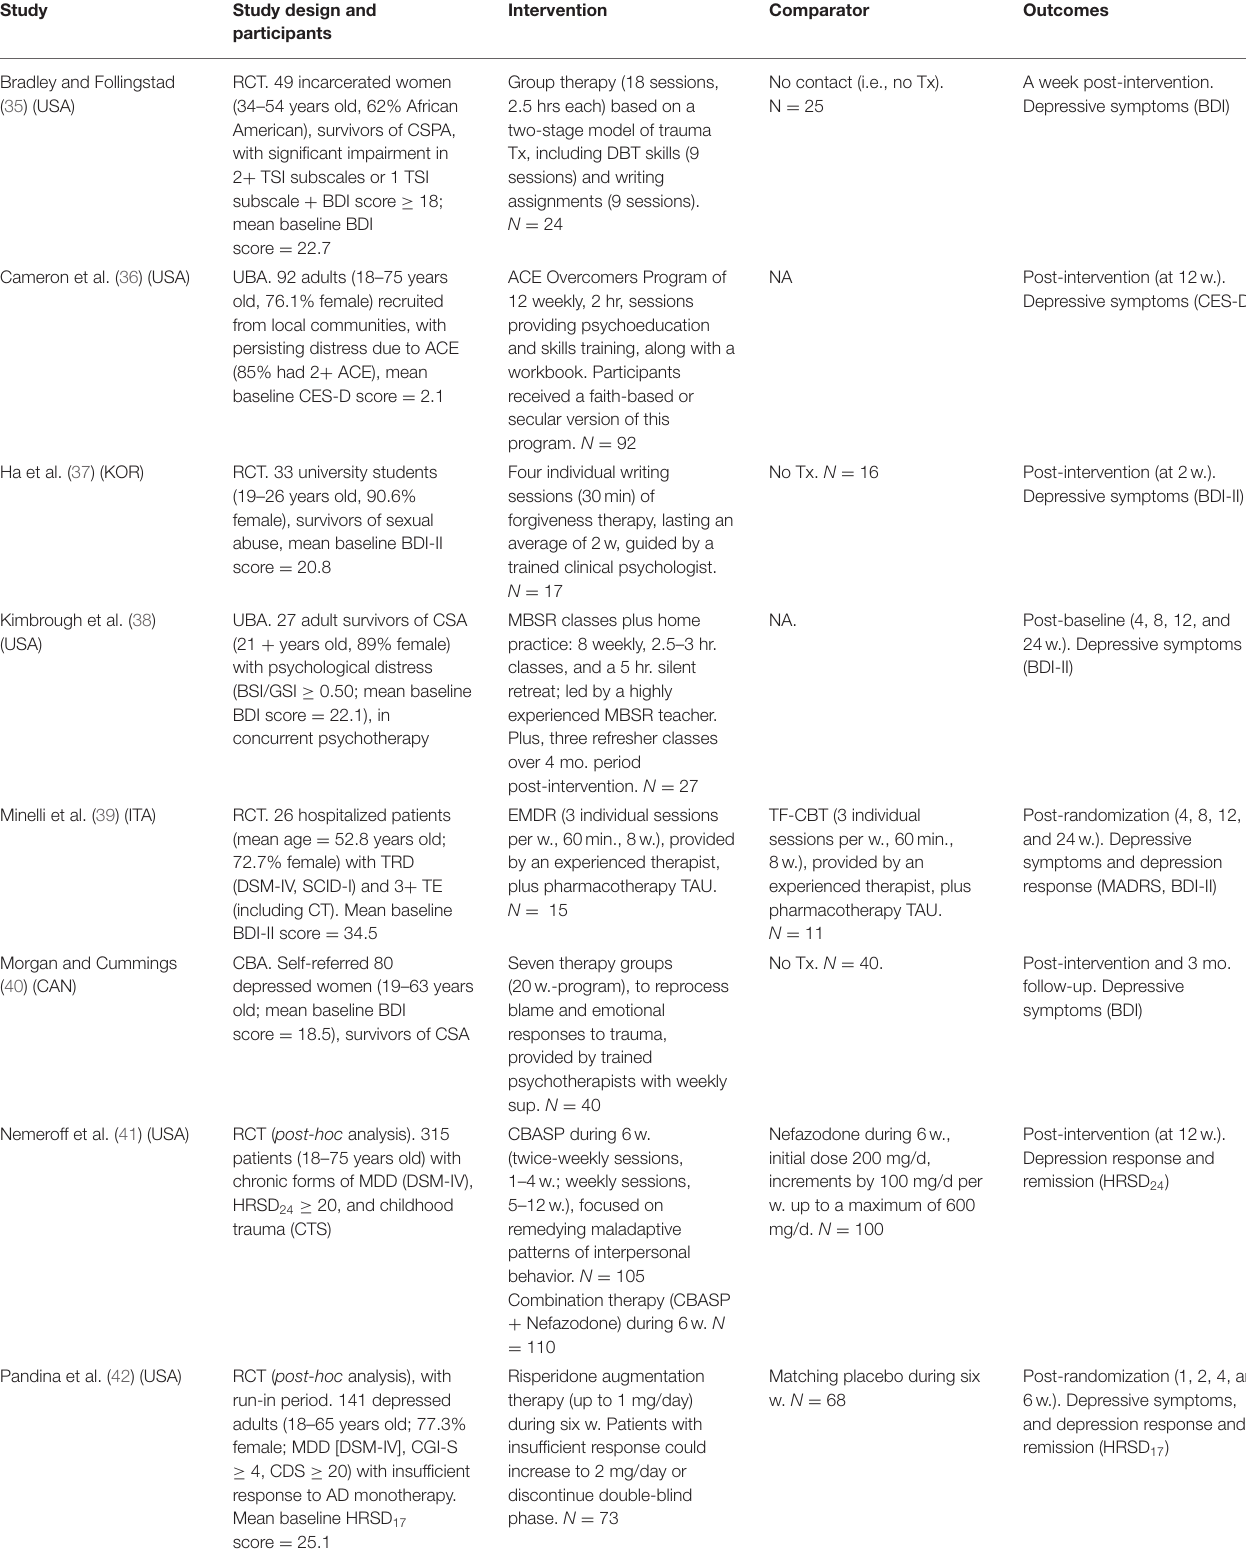
TABLE 1 | Characteristics of included studies.